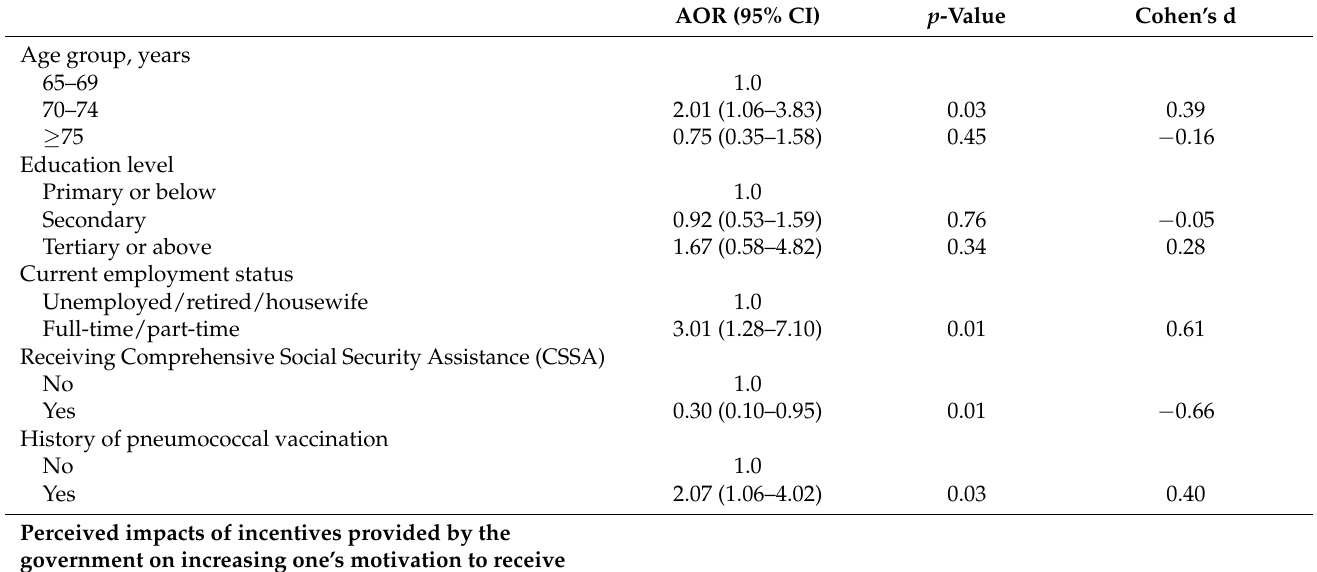
Table 5. Summary model of factors associated with completion of primary COVID-19 vaccination series among older adults in Hong Kong (n =